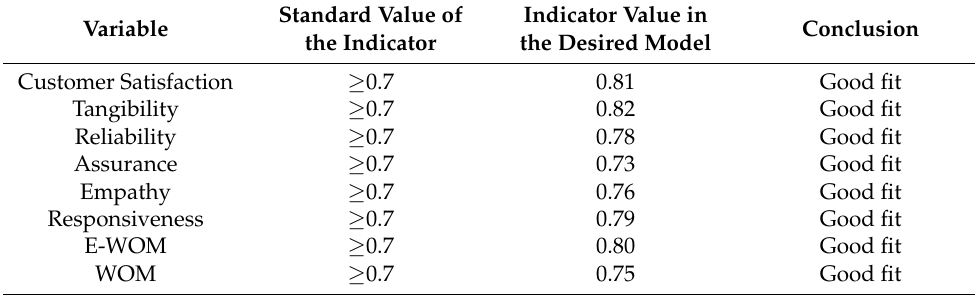
Table 4. Composite reliability (CR).